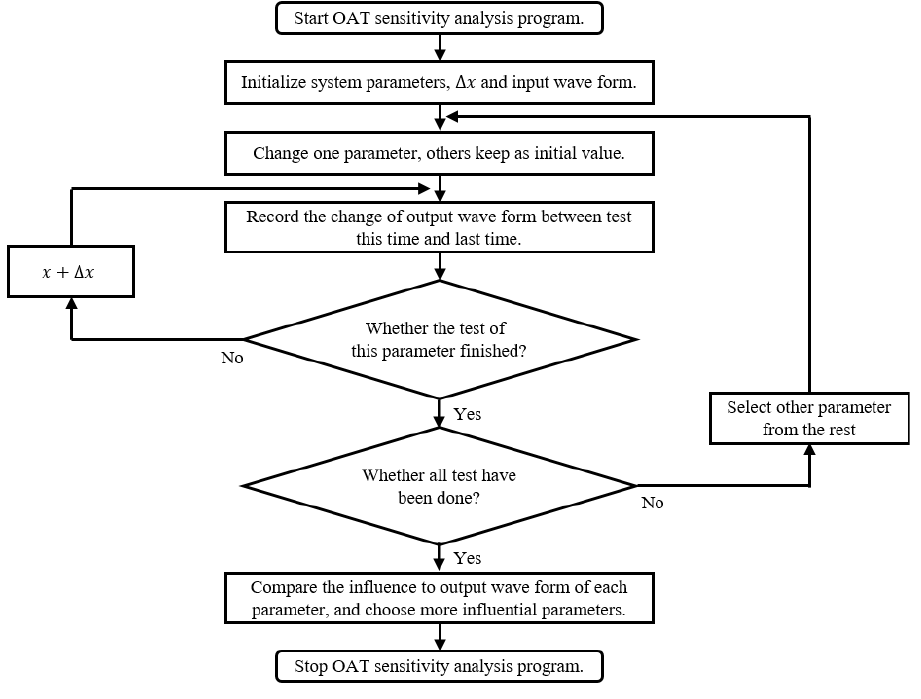
Figure 10. The OAT sensitivity analysis flowchart .